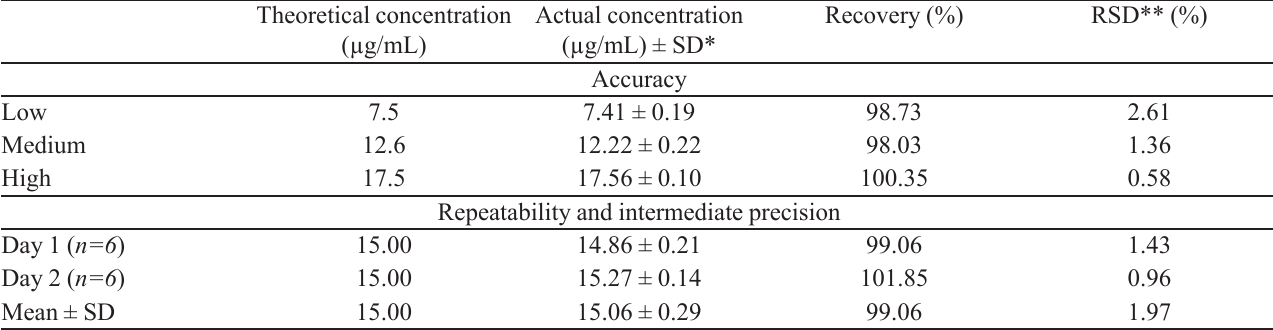
*SD= Standard Deviation **RSD= Relative Standard Deviation.